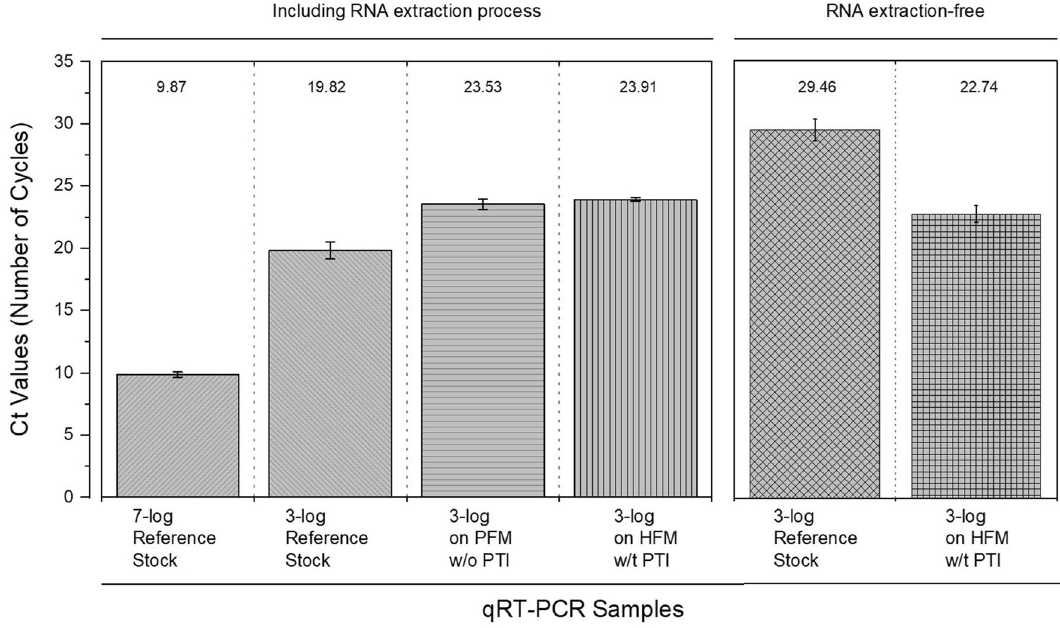
Figure 7. Comparison of the cyclic threshold (Ct) values of each infectious sample for detecting the M-gene of the H1N1 pdm09